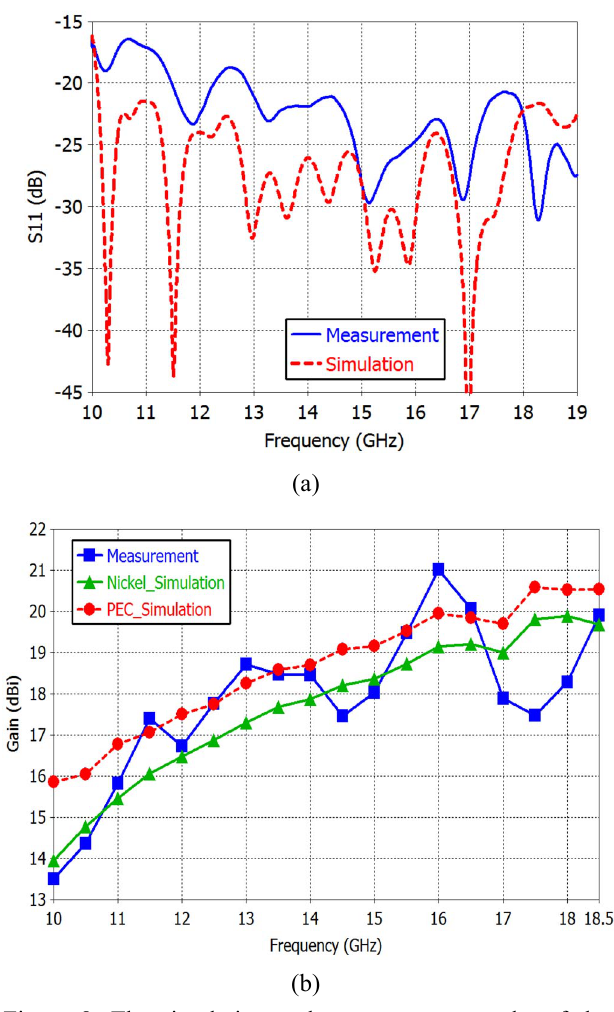
Figure 8: The simulation and measurement results of the antenna manufactured with 3-D printing and coating technique for (a) S 11 parameter and (b)